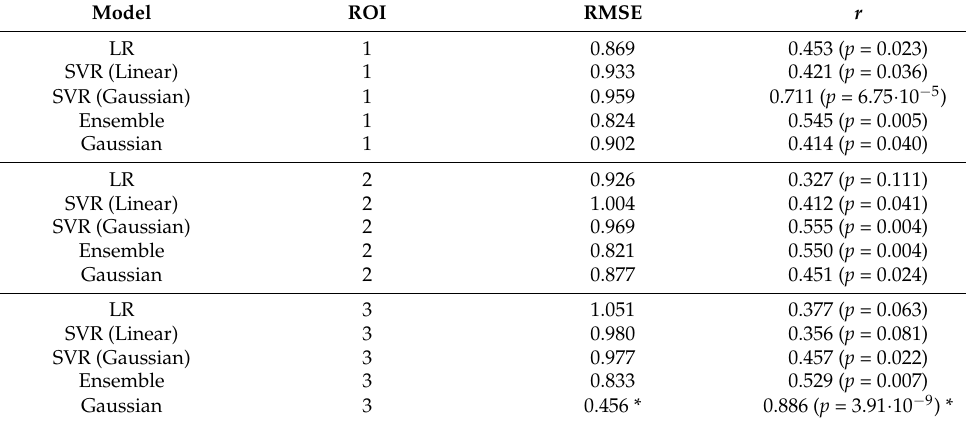
Table 2. Results of the regression obtained by the several ML approaches considered to estimate the ARV from the thermal metrics. Notably, the performance of the model was expressed as root-mean- square error (RMSE) computed on the normalized (z-score) values and the correlation coefficient ( r ) between the gold standard (EMG-based ARV) and the predicted metric (IRI-based ARV). The best model is highlighted with an